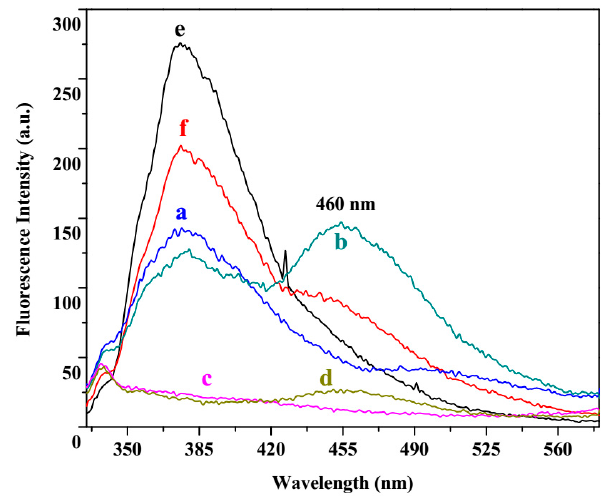
Figure 9. Comparative fluorescence spectra of (a) MSN-Et 3 N-IPTMS-hpbtz- f1 , (b) MSN-Et 3 N-IPTMS- hpbtz- f1 + Zn 2+ , (c) MSN-pyridine-IPTMS-hpbtz- f2 , (d) MSN-pyridine-IPTMS-hpbtz- f2 + Zn 2+ , (e) MSN-NaOH-IPTMS-hpbtz- f3 , and (f) MSN-NaOH-IPTMS-hpbtz- f3 + Zn 2+ , upon the addition of Zn 2+ (15.4 equivalent, 350 µL) at a concentration of 10 − 3 M in ethanol ( λ ex = 305 nm).